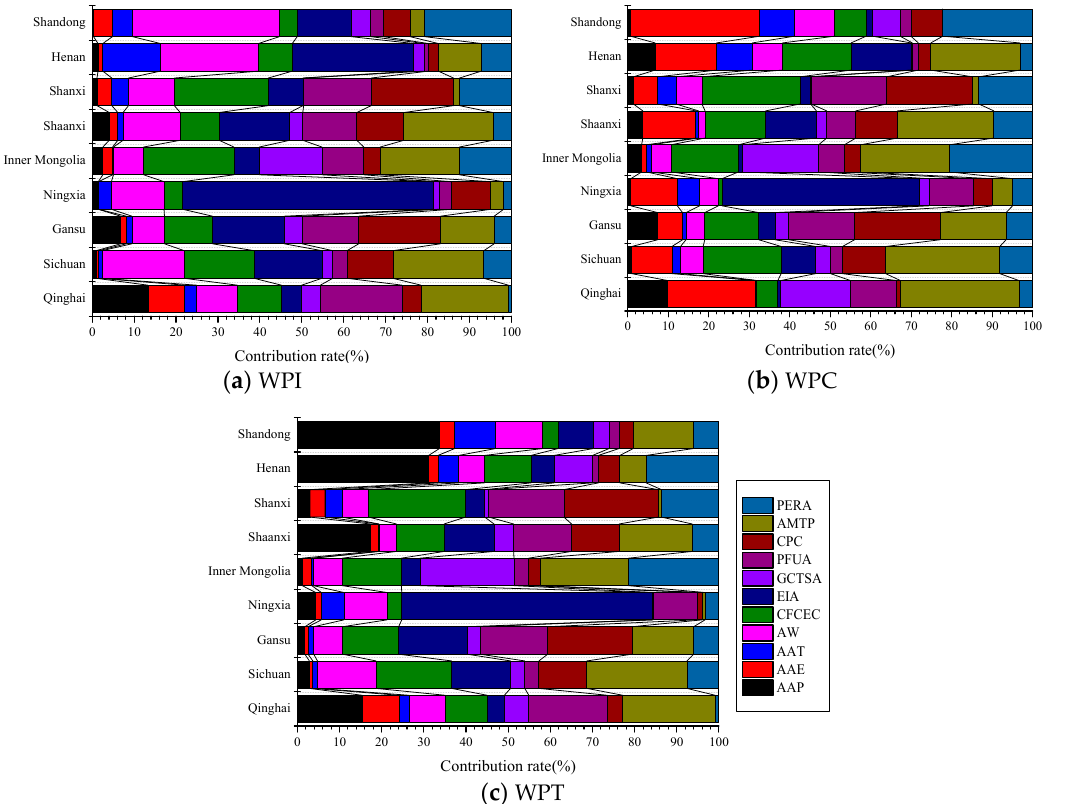
Figure 7. The relative contribution rate of the influencing factors to water productivity. ( a ) Relative contribution rate of the influencing factors to WPI of the provinces (autonomous regions). ( b ) Relative contribution rate of the influencing factors to WPC of the provinces (autonomous regions). ( c ) Relative contribution rate of the influencing factors to WPT of the provinces (autonomous regions).